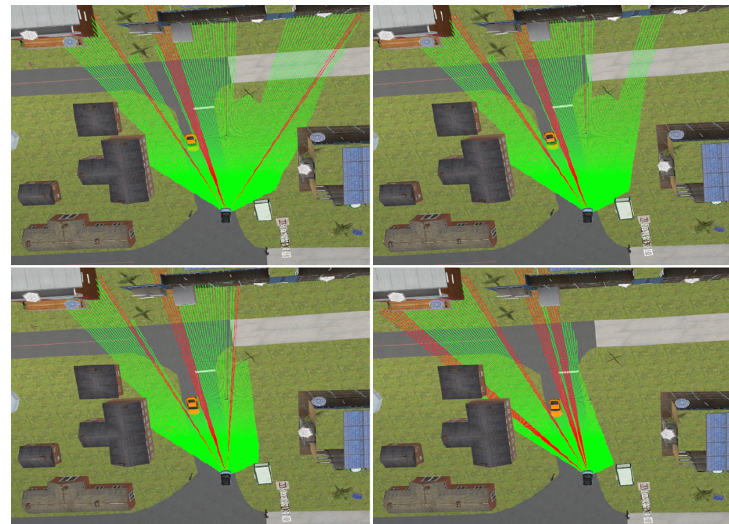
Figure 5. Fields of view of each LiDAR’s layer in each subfigure. Red rays are those that do not find any target, whose length is the LiDAR maximum depth (200 m for the IBEO Lux); green rays refer to those that collide in the 3D space, with a length that is the distance between the sensor and the target.